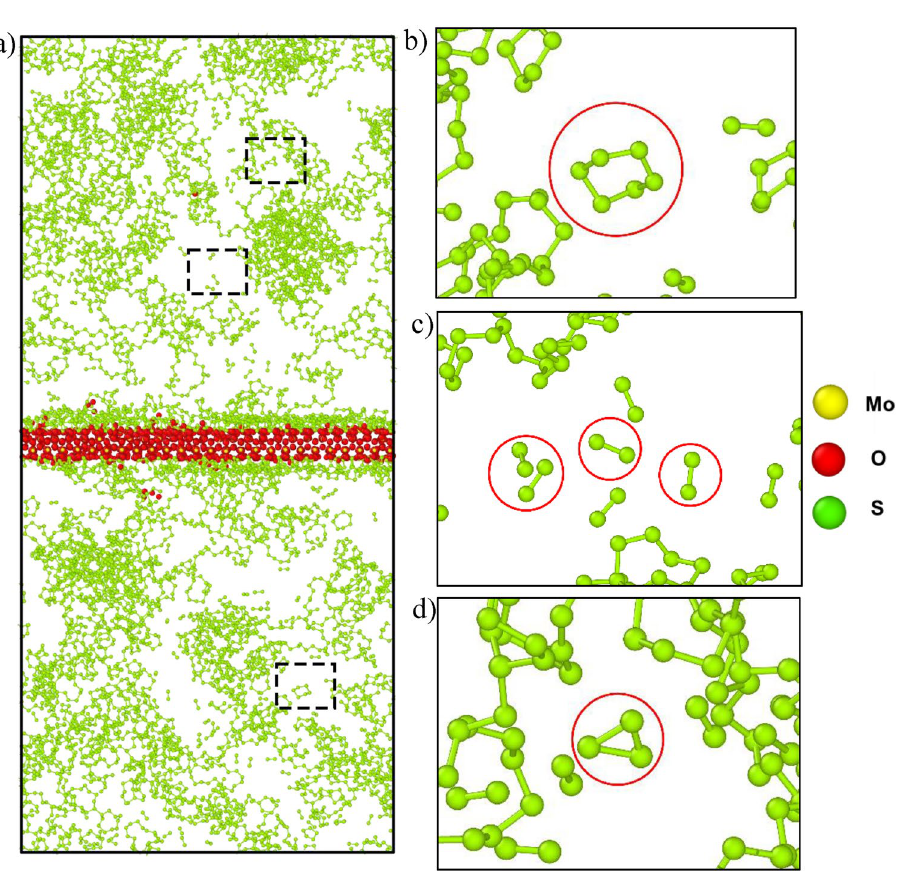
Figure 8. Structure evolution due to the reduction of S 2. ( a ) Snapshot of the simulation at 50 ps and the formation of ( b ) S6, ( c ) S2, and ( d ) S3